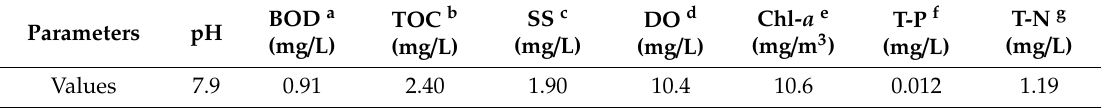
Table 1. Water quality of raw water supplied to both water-treatment plants.